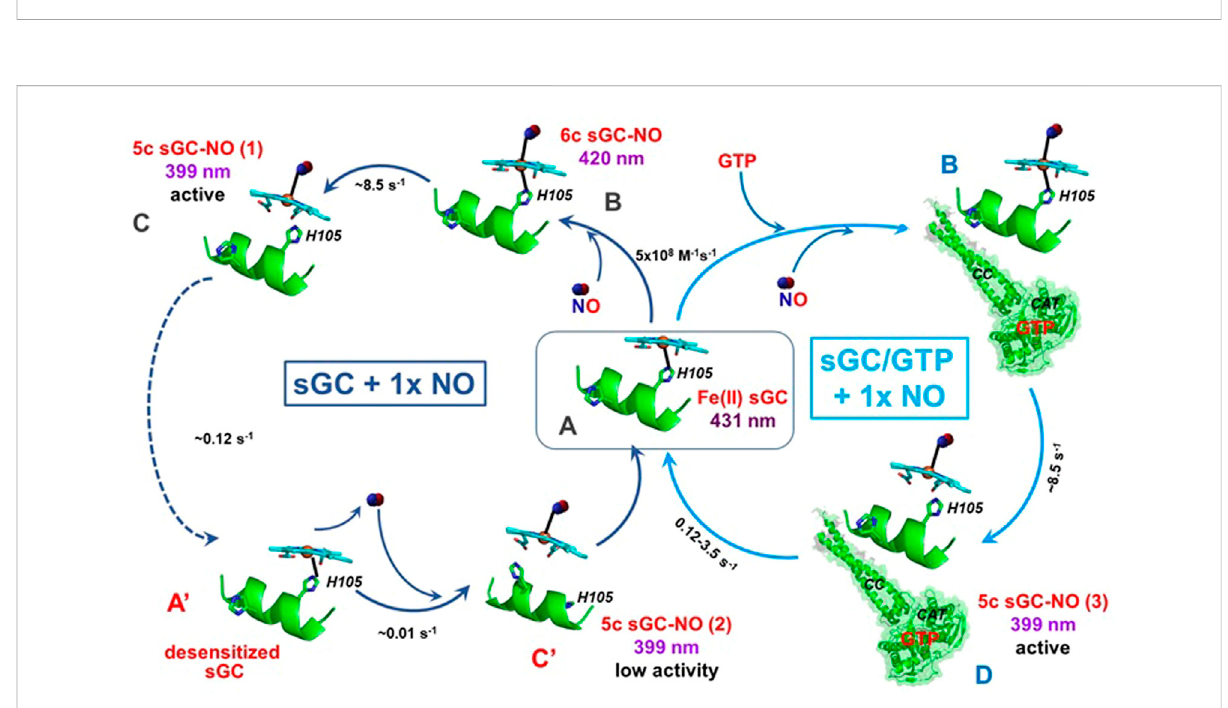
FIGURE 3 Interactions between sGC with stoichiometric NO. In the absence GTP (blue, left circle), sGC (A) binds stoichiometric NO to form 6c sGC-NO complex (B) , which converts into the 5c sGC-NO d (C) complex. The 5c sGC-NO d is fully active, but converts into a desensitized form of sGC (A 9 ) , which binds NO very slowly to form a low activity 5c sGC-NO d complex (C 9 ) . In the presence of GTP (cyan, right circle), 5C sGC-NO d does not convert to the desensitizedform ofsGC, presumablydue to the conformational effects inducedbyGTP. Instead, theactive conformation (D)